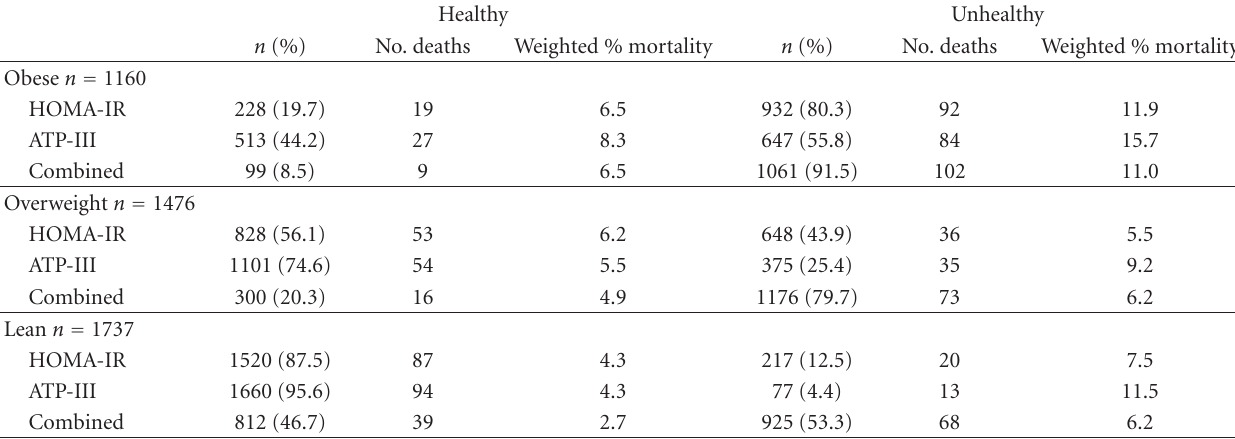
Table 2: Number of participants defined as healthy or unhealthy by three definitions of metabolic health, and mortality rate in each